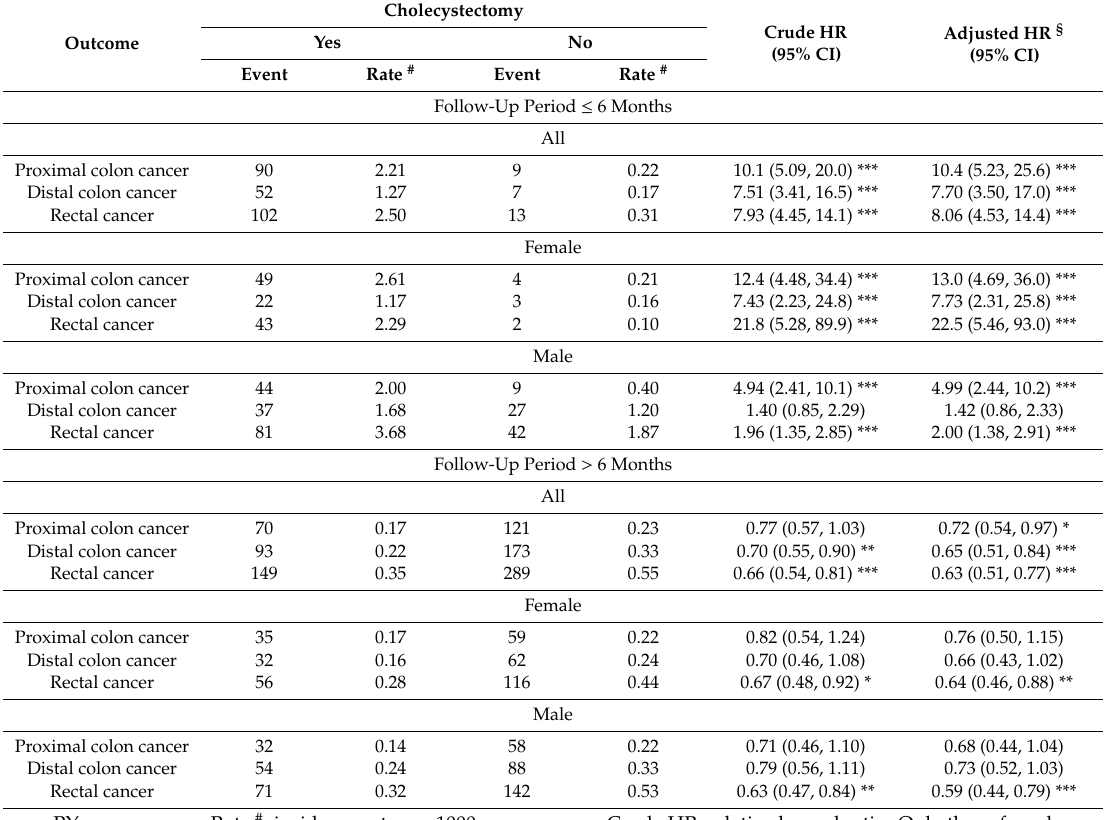
Table 4. The comparison of the colon cancer incidence densities between gallbladder stones patients with and without cholecystectomy, stratified by sex, location of cancer, and follow-up duration.